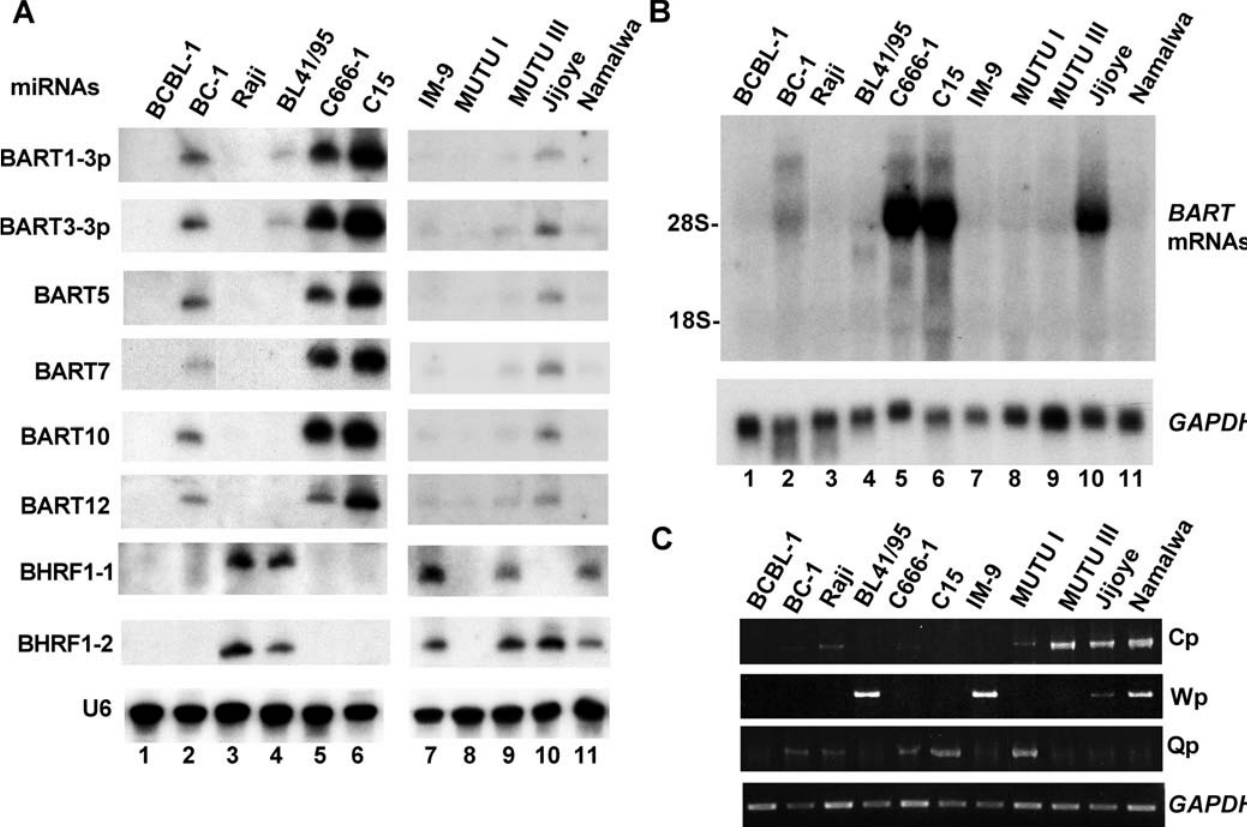
Figure 2. Analysis of EBV miRNA and mRNA Expression in Tumor-Derived Cells (A) Northern analysis of selected EBV miRNAs in total RNA samples derived from the indicated cell lines and tumors. The EBV uninfected PEL cell line BCBL-1 served as a negative control and U6 RNA as a loading control. (B) Northern analysis of BART mRNA expression. The total RNA samples analyzed here are the same ones used in (A). The probe used was specific for the invariant exon 7 of the alternatively spliced BART miRNAs. GAPDH mRNA expression was used as a loading control. The mobility of 28S and 18S rRNA is indicated. (C) RT-PCR analysis using primers specific for transcripts initiating at the viral Cp, Wp, and Qp promoters. This analysis used oligo(dT)-primed cDNA preparations. Primers specific for the cellular GAPDH mRNA were used as a control. DOI: